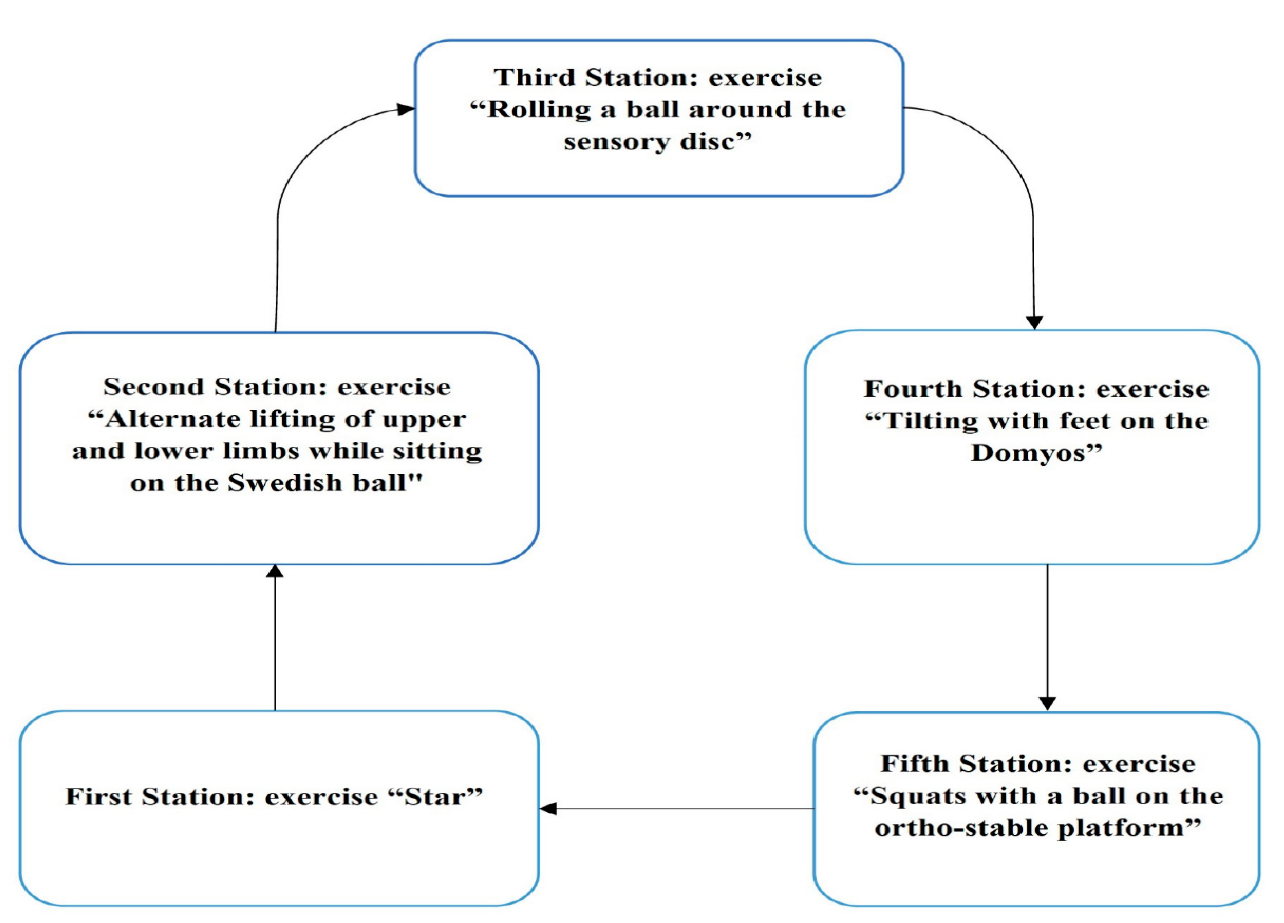
Figure 3. Diagram showing the location of the stations and the direction of movement of the exer- cising participants. exercising